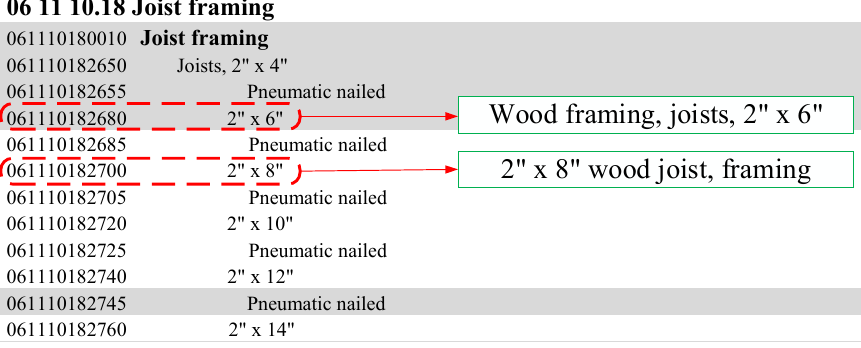
Figure 2. Work descriptions (adapted from RSMeans online [2]).